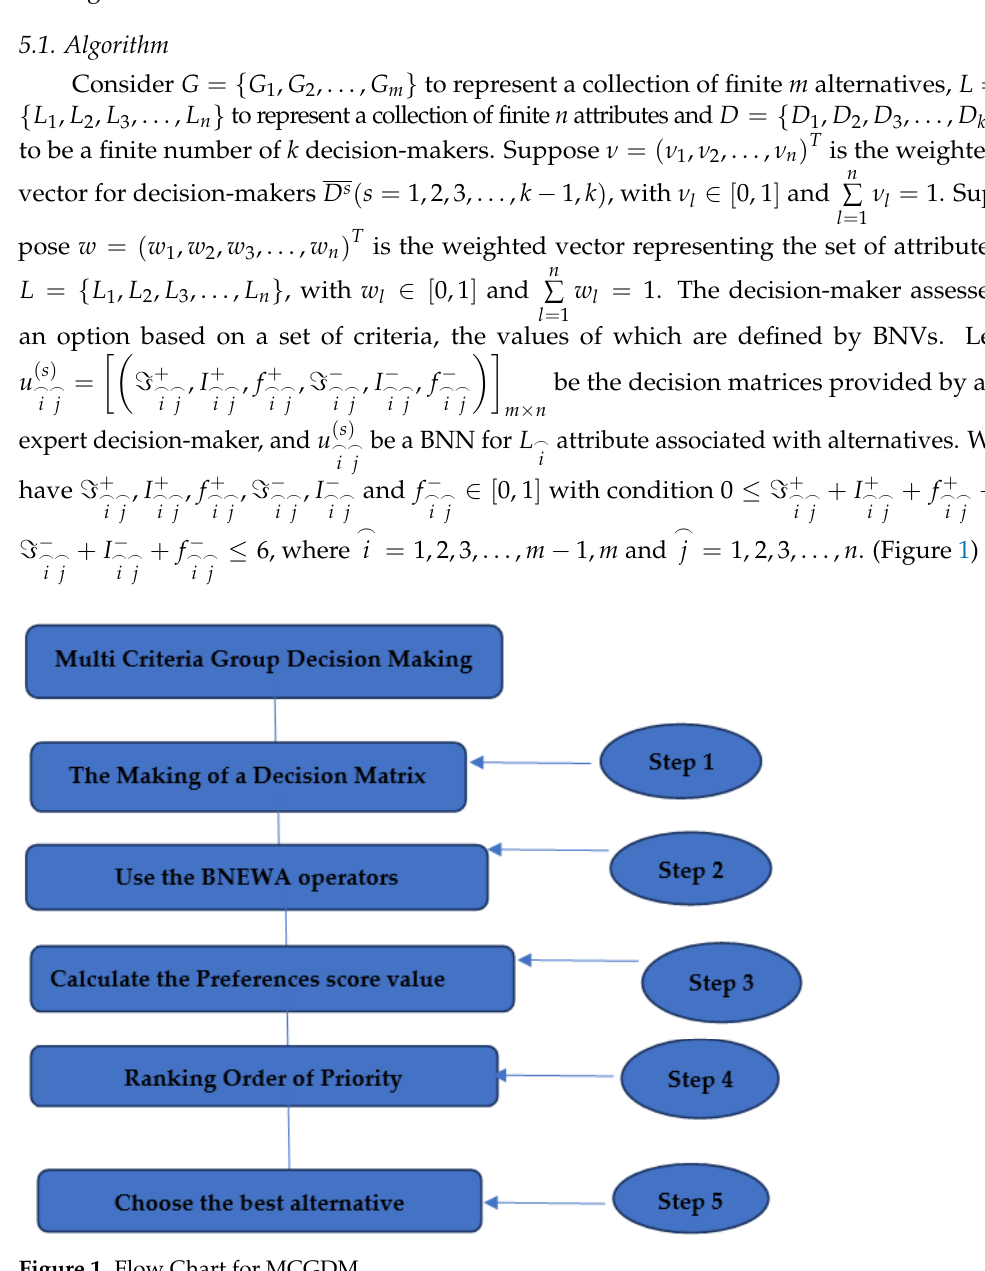
Table 1. BN decision matrix by decision-maker D 1 .